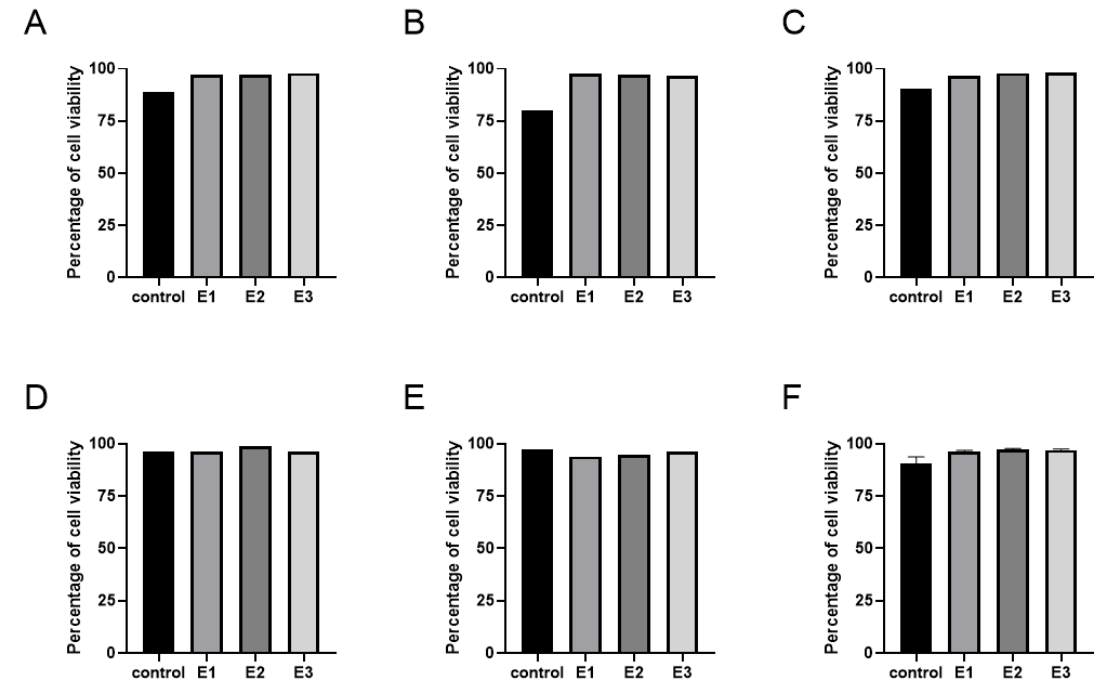
Figure 1. Cell viability at the end of the 6th passage of the experiment. The graphs demonstrate the percentage of living cells in the population of cell line 1 ( A ), cell line 2 ( B ), cell line 3 ( C ), cell line 4 ( D ), cell line 5 ( E ), and as a mean of lines 1–5 with SEM plotted as an error bar ( F ). Cells were cultivated in a standard medium (control) and experimental media 1–3 (E1–3). No statistical significance between the control and experimental groups was found.